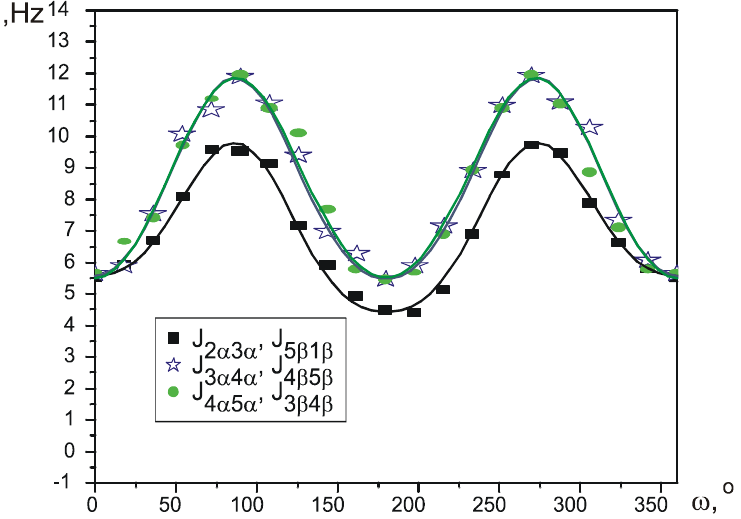
Figure 5. Pseudorotation angle dependency parameters for vicinal cis-SSCCs in trans-1,2-